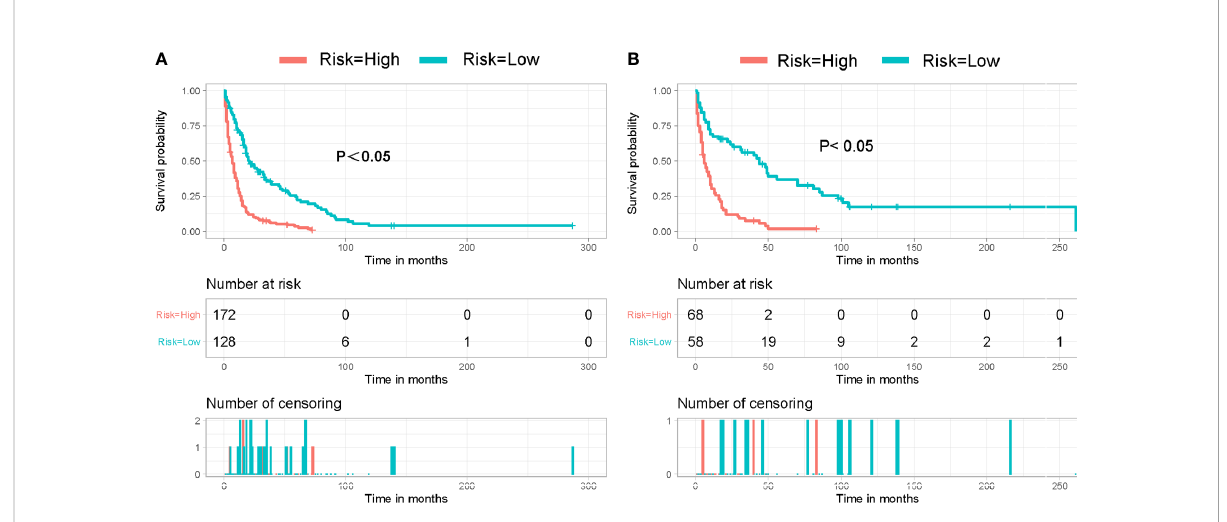
FIGURE 5 Kaplan – Meier survival curve for patients in different risk groups in both cohorts: (A) training cohort and (B) validation